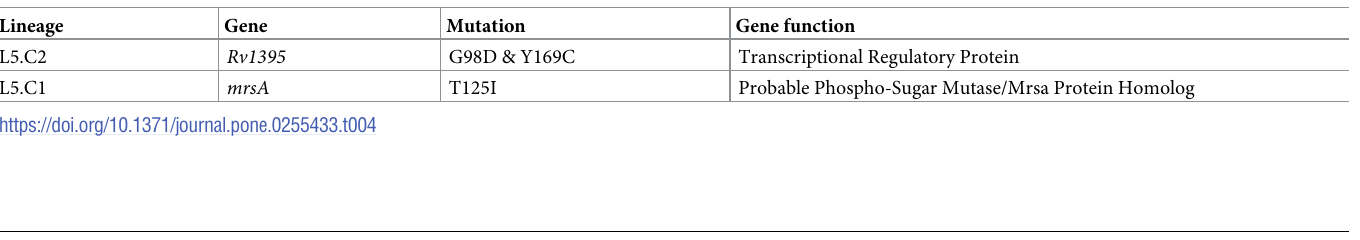
determined with a clinical strain of M . bovis used as a control. All mycobacterial isolates used